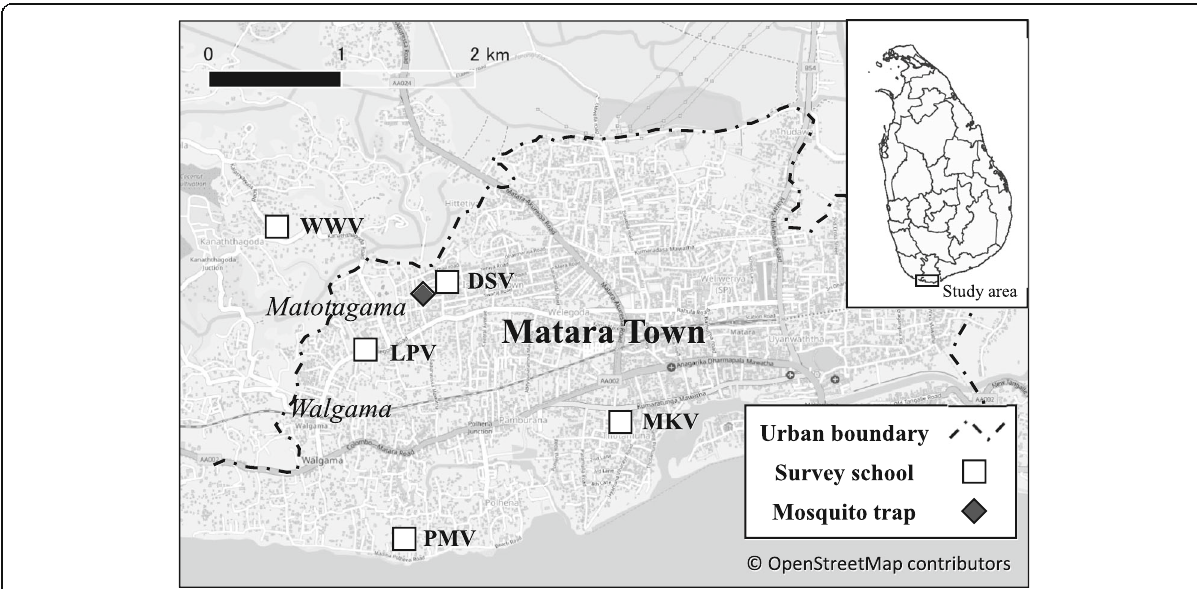
Fig. 1 Location of surveyed schools, mosquito trap,s and spatial distribution of anti-filarial IgG4 values in Matara. The map shows the location for survey area: Matara is located in the southern part of Sri Lanka. Five schools (DSV, LPV, WWW, PMV, and MKV) surveyed for schoolchildren IgG4 are shown as white box. Black diamond indicates the location of CDC Gravid Traps for collecting Cx . quinquefasciatus . The center coordinates of the eight Traps are approximately N5.954128, E80.522119